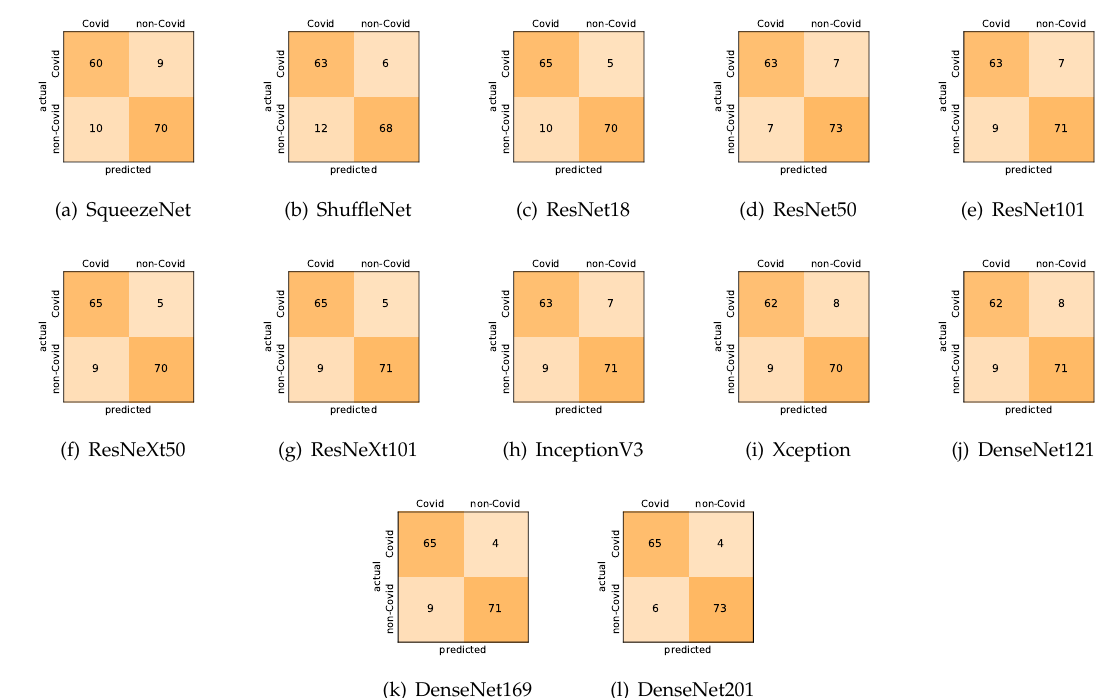
Figure 10. Confusion matrices for the different deep CNN models. These results are the average counts of the five models obtained by stratified 5-fold cross-validation on the COVID19-CT